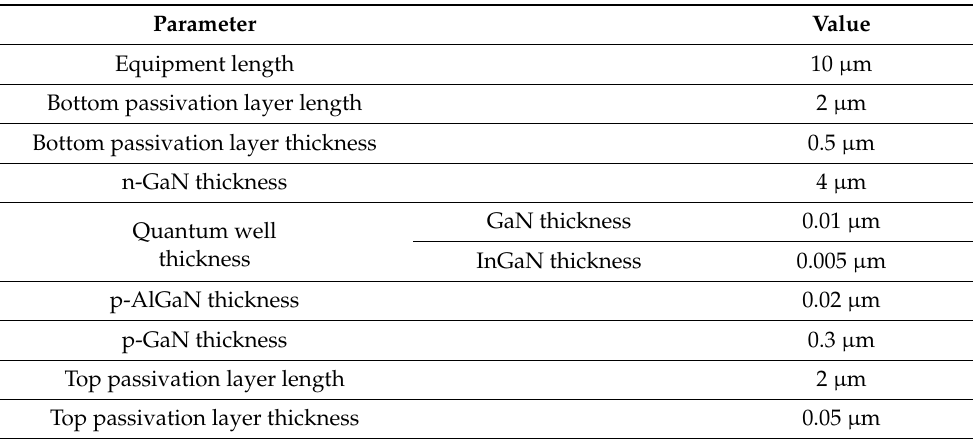
Table 2. Summary of Basic Parameters of Epitaxial Structure.